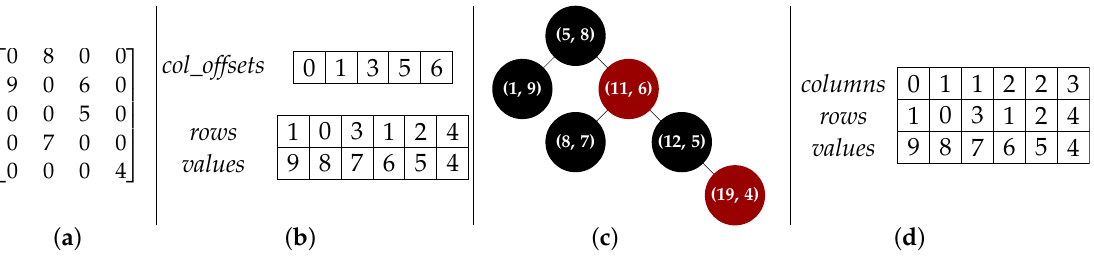
Figure 2. Illustration of sparse matrix representations: ( a ) example sparse matrix with 5 rows, 4 columns and 6 non-zero values, shown in traditional mathematical notation; ( b ) corresponding Compressed Sparse Column (CSC) representation; ( c ) corresponding Red-Black Tree (RBT) representation, where each node is expressed by ( i , v ) , with i indicating a linearly-encoded matrix location and v indicating the value held at that location; ( d ) corresponding Coordinate list (COO) representation. Following C++ convention [2], we use zero-based